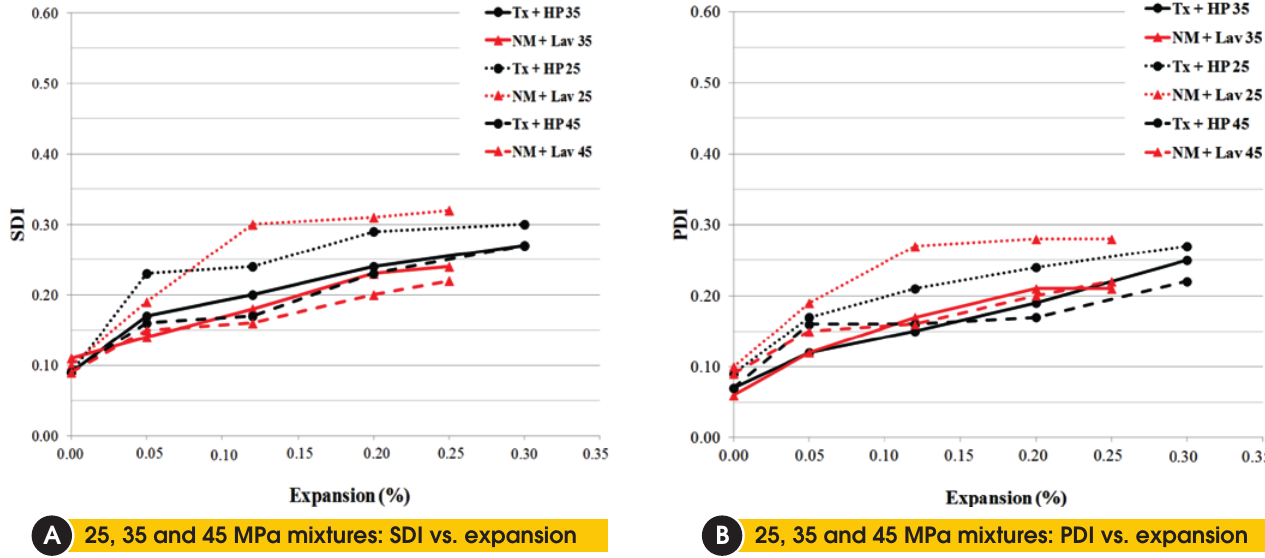
25, 35 and 45 MPa mixtures: SDI vs. expansion 25, 35 and 45 MPa mixtures: PDI vs. expansion Stiffness Damage Test results in terms of indices for the 25, 35 and 45 MPa mixtures: A) Stiffness Damage Index (SDI) and; B) Plastic Deformation Index (PDI)